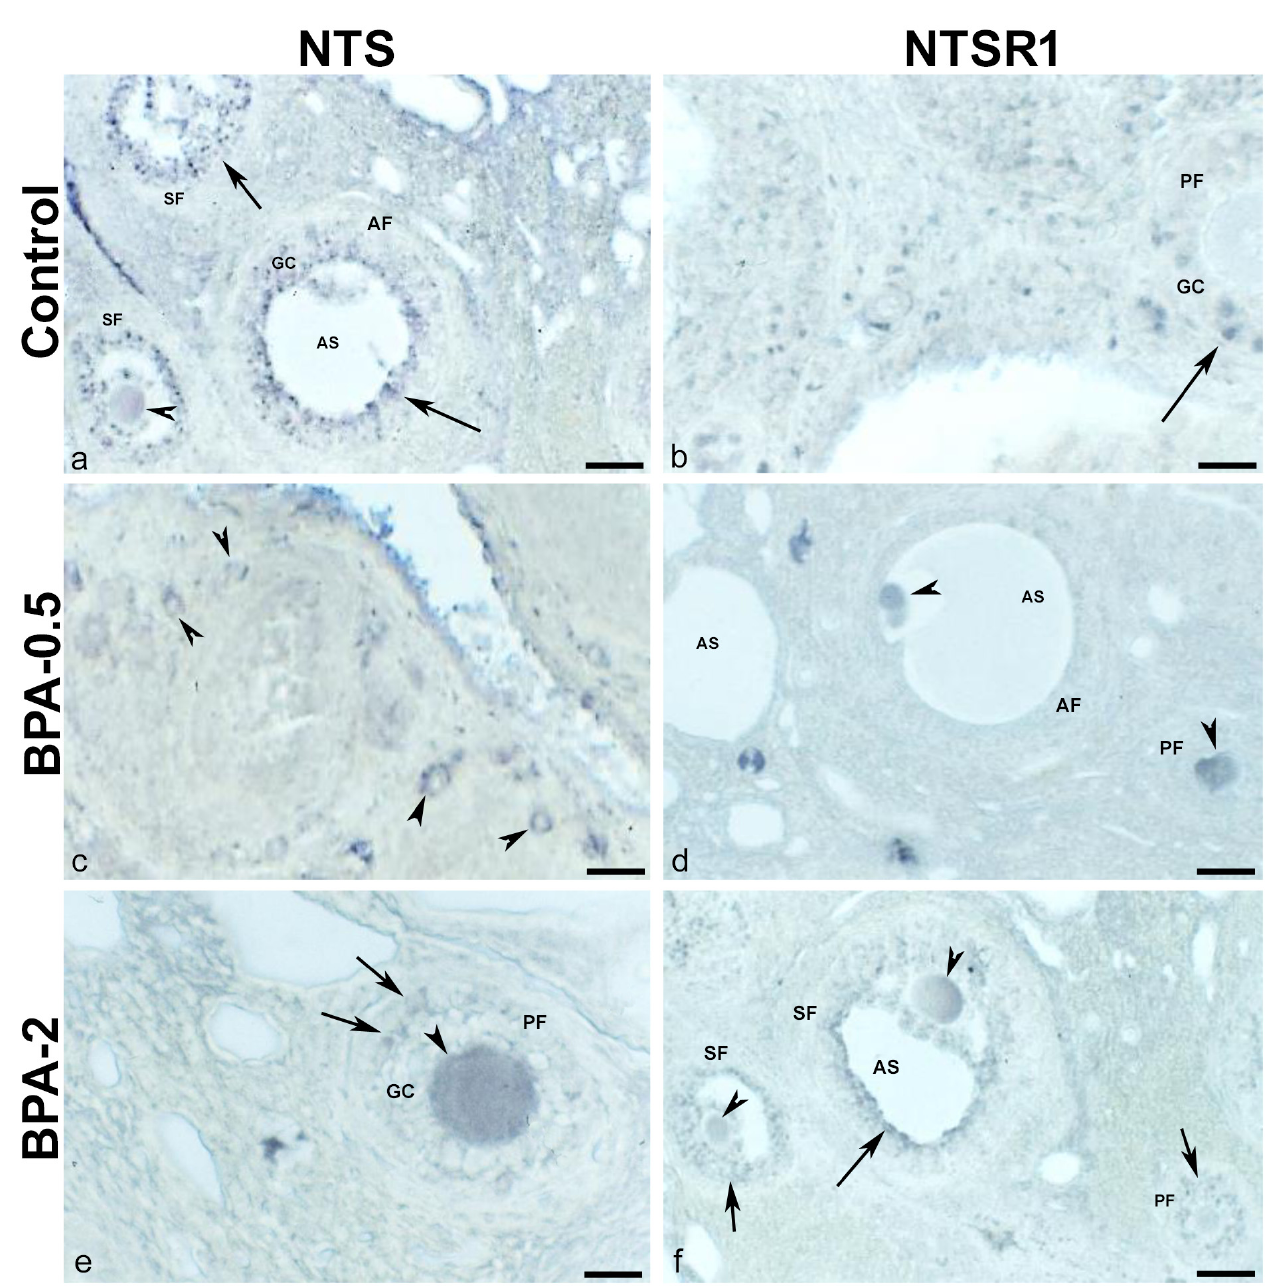
Figure 10. NTS and NTSR1 immunoreactivity in the mother’s ovaries. Representative images of the ovary in mothers after weaning/lactation showing the presence of NTS-ir ( a , c , e ) and NTSR1-ir ( b , d , f ) in oocytes (arrowheads) and granulosa cells (arrows) in the different follicles in the three experimental groups. AF: antral follicle; AS: antral space; GC: granulosa cells; PF: primary follicle; SF: secondary follicle. Scale bars: ( a , c , d , f ): 40 µm; ( b , e ): 20 µm.